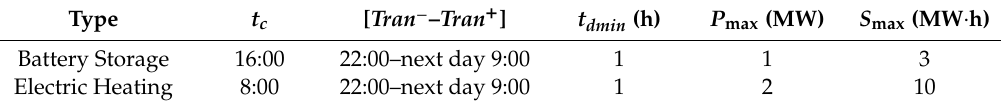
Table 3. The Parameters of Transferable